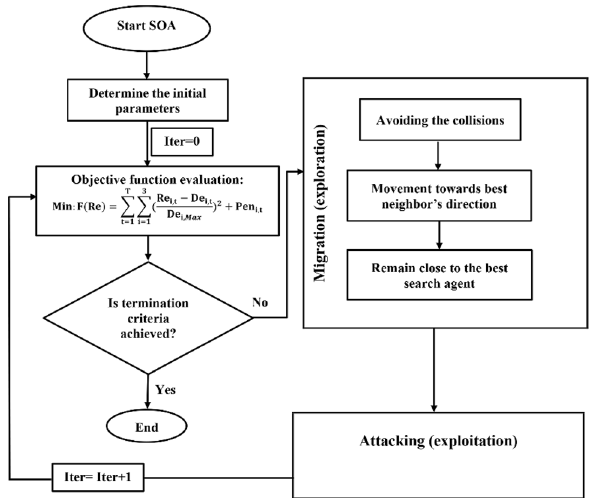
Figure 3. Flowchart of SOA algorithm in the optimal operation of Halilrood multi-reservoirs system.